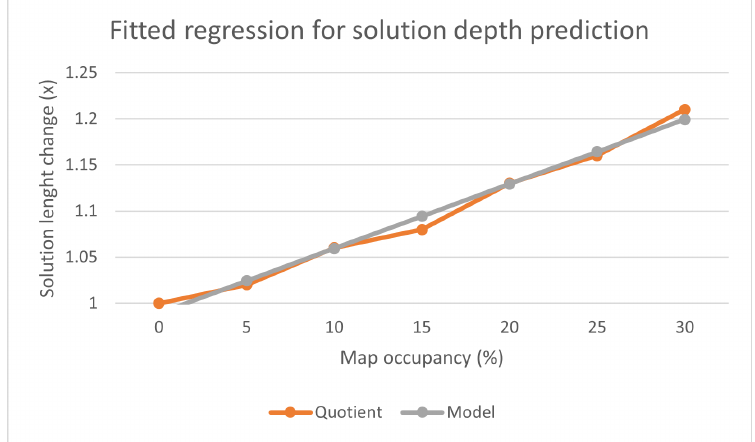
Figure 12. Trained linear regression model.